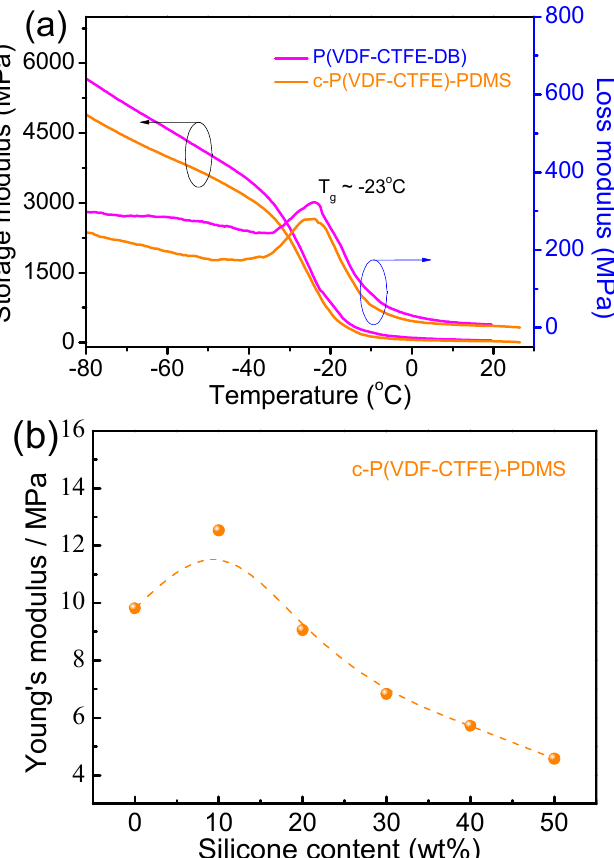
Figure 6. ( a ) DMA curves of neat matrix and hybrid containing 30 wt % PDMS-NH 2 , and ( b ) the modulus of the hybrids with various silicone contents at room temperature.